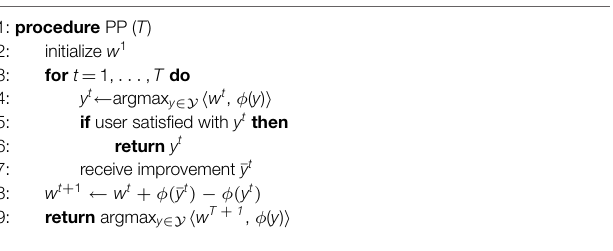
Algorithm 3 | The Preference Perceptron algorithm (Shivaswamy and Joachims,